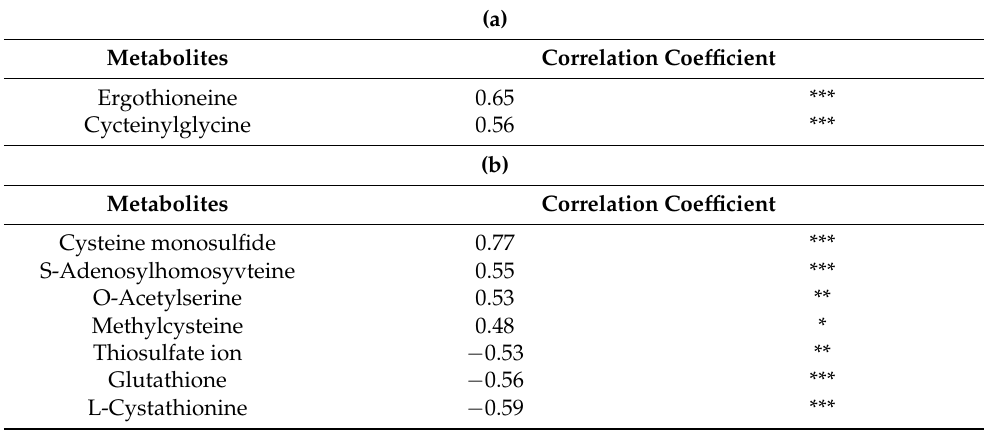
Table 2. Significant correlation coefficient with radon inhalation days and radon concentration (Bq/m 3 ). ( a ) Correlation coefficient with radon inhalation days. ( b ) Correlation coefficient with radon concentration.